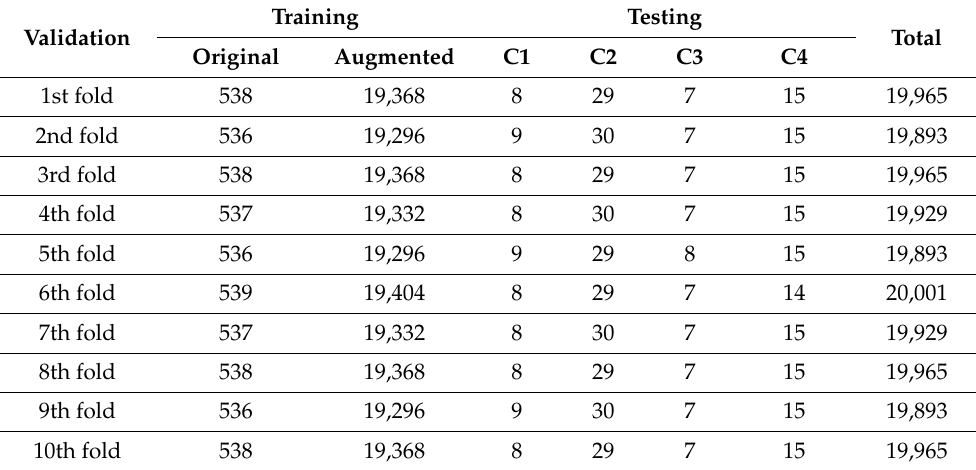
Table 5. Summary of 10-fold cross-validation of training and testing data for closed-world configura- tion (unit: